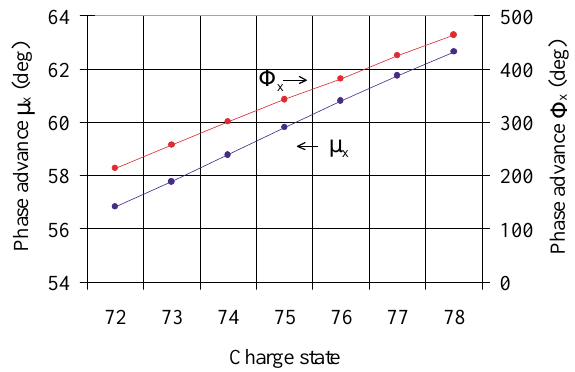
FIG. 9. (Color) Phase advance over the period m x and total phase advance F x (modulo 360 ±